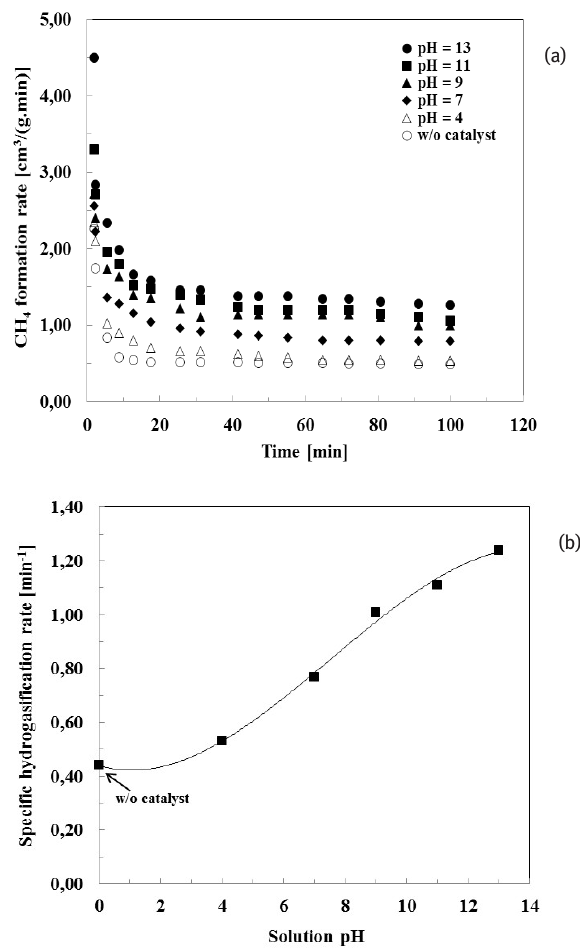
Figure 5: Effect of solution pH during isothermal catalytic coal hydrogasification at 850°C (catalyst: potassium carbonate, 20% w/w) on (a) the CH formation rate, (b) specific hydrogasification 4